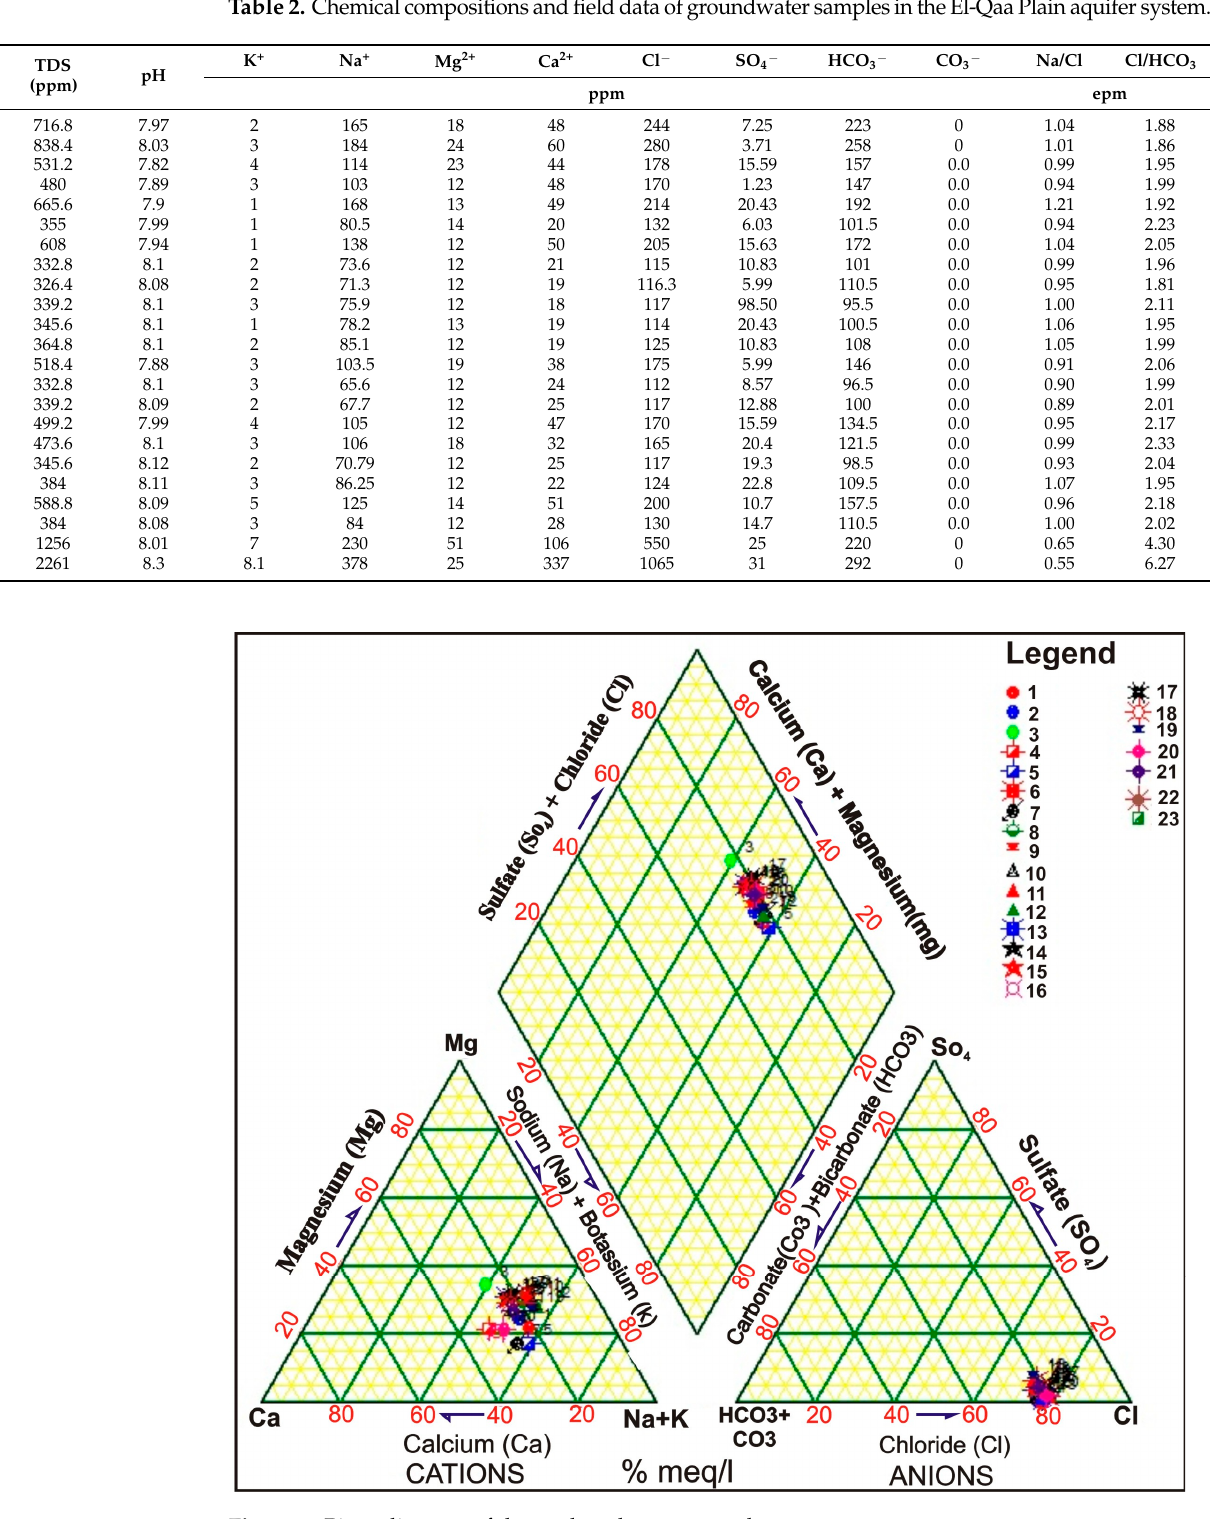
Figure 5. Piper diagram of the analyzed water samples. Table 2. Chemical compositions and field data of groundwater samples in the El-Qaa Plain aquifer system.